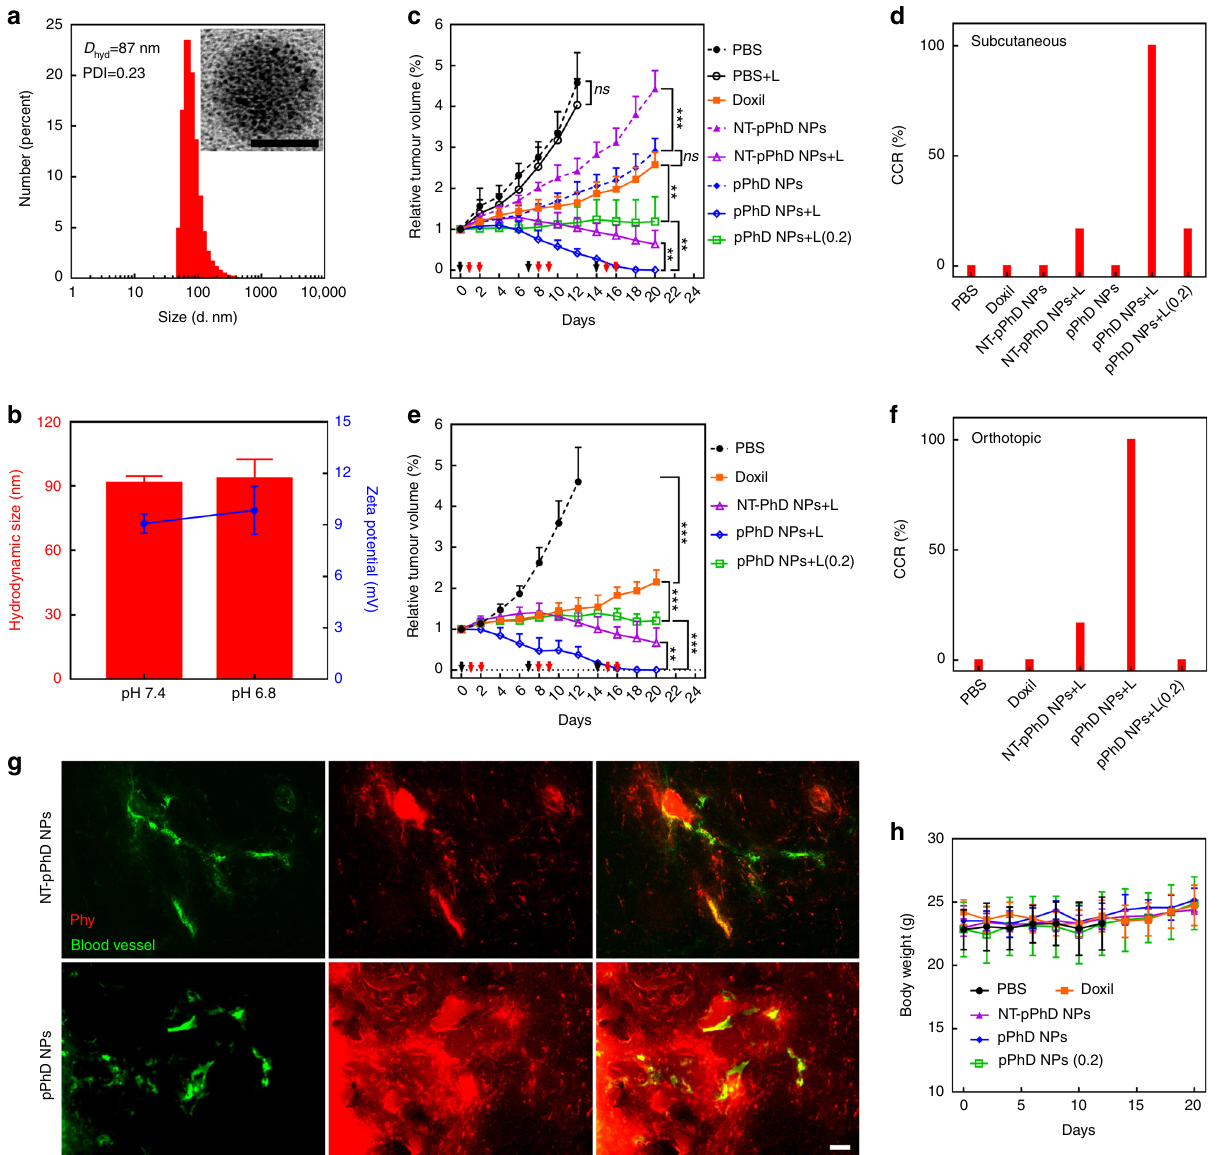
Fig. 6 In vivo investigation of transformability, chemotherapeutic delivery and photodynamic effect. a Size distribution and morphology of NT-pPhD NPs. The inset is TEM micrograph with a scale bar of 50 nm. b Size and surface charge changes of NT-pPhD NPs before and after the stimulation at pHe (6.8). c The tumour volume changes on subcutaneous tumours ( n = 6) after administration of various treatment groups. The black arrows denote the nanoparticles administration, and red ones point out the tumour treated by laser treatments. d The complete cure rate (CCR%) of the subcutaneous tumours. e The tumour volume changes on orthotopic tumours ( n = 6). f The CCR% of the orthotopic tumours. g The microscopic distribution of transformable nanoparticles (pPhD NPs) in tumour tissue in comparison with the non-transformable pPhD NPs (NT-pPhD NPs) to prove the superior tumour penetrations. The blood vessel (green) was stained by FITC-dextran (70k) while the red fl uorescence indicated the distribution of nanoparticles. The scale bar is 50 µ m. h Body weights changes of tumour-bearing mice after treatment ( n = 6). The treatment doses were set as 4.7 mg kg − 1 for Doxil (calculated by DOX concentration), 5.3 mg kg − 1 for Phy, 10 mg/kg for NT-pPhD NPs and 10 mg kg − 1 for pPhD NPs (NT-pPhD NPs and pPhD NPs both were calculated based on the concentration of PhD monomer), respectively. For the group of treated with pPhD NPs at low laser dose, the laser (680 nm) dose was set to 0.2 W cm − 2 for 6 min. The other laser-treated groups were all set as 0.4 W cm − 2 for 3 min. * p < 0.05; ** p < 0.01; *** p < 0.001; ns , not signi fi cant. All error bars are presented as standard deviation. Note: the mice were immunode fi cient, the laser treatments on right tumour were not able to induce immuno-responses to affect the left